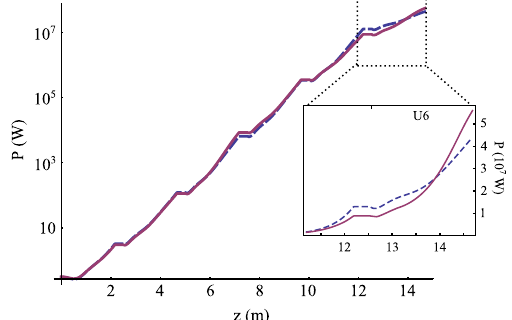
FIG. 6. Comparison between GENESIS (blue dashed) and SLAP (amaranth continuous) for the whole undulator length. A detail, in linear scale, for the last undulator section is shown in the square. The length of the undulator takes into account also the drifts (steps in the graphic) between one undulator and the following one. Results are obtained using the e-beam parameters at the linac exit reported in Table